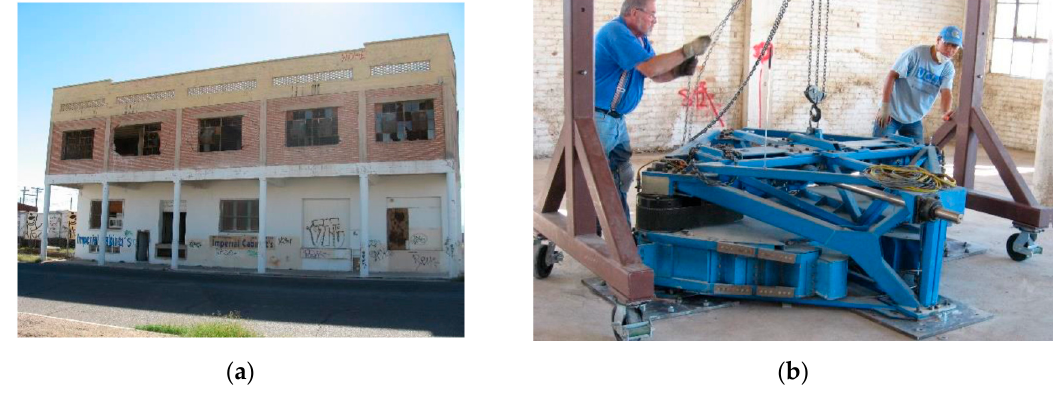
Figure 13. ( a ) North view of the structure; ( b ) Eccentric mass shaker.